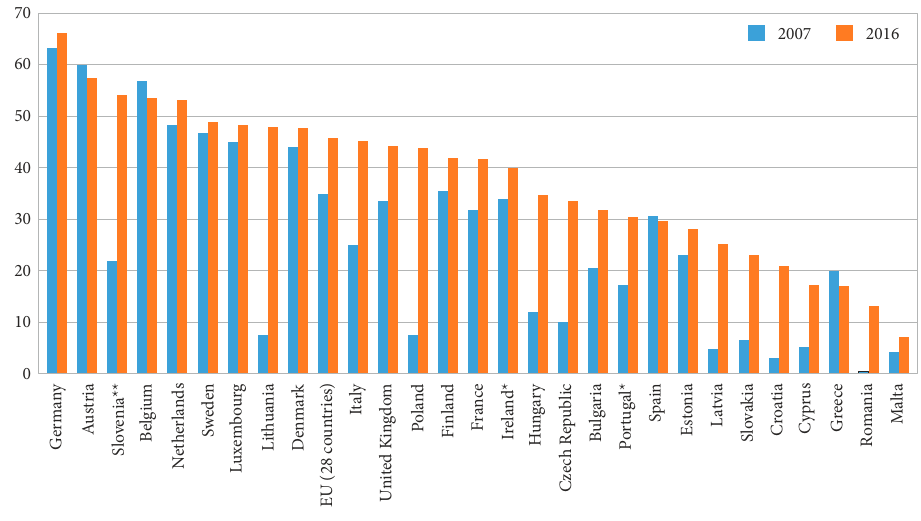
Figure 2. Recycling rate of municipal waste in EU countries (source: Own elaboration based on Eurostat, 2018) Notes: *2014 for Ireland and Portugal, ** 2015 for